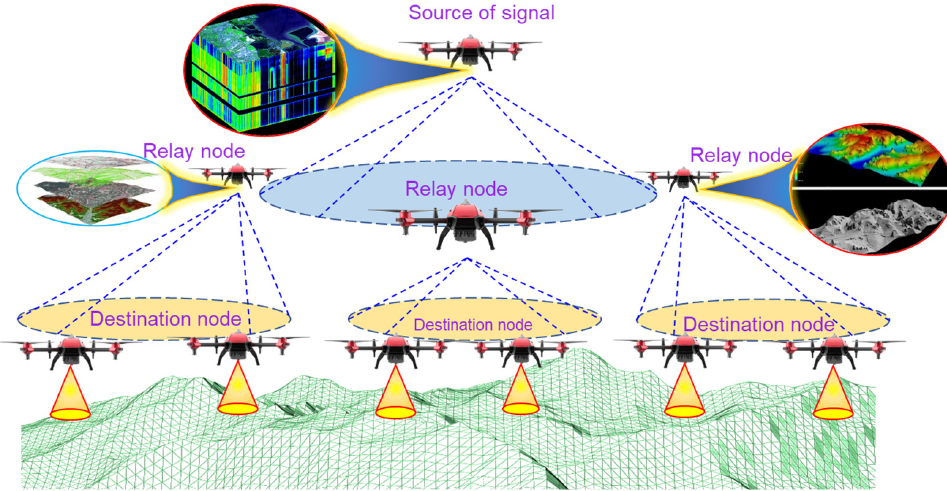
Figure 1. Demonstration of cooperative communication process in a cluster network.